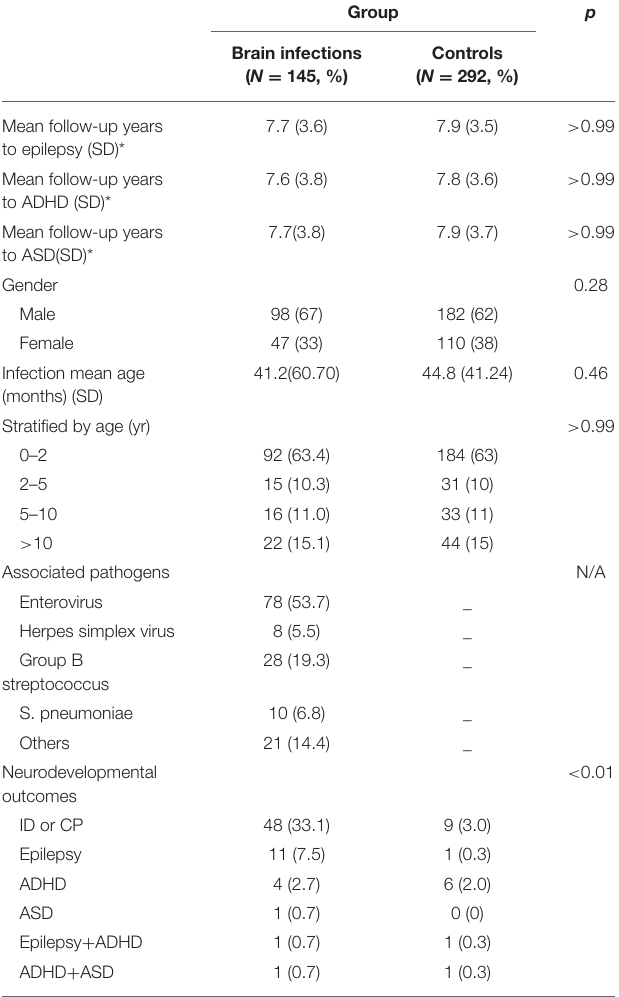
TABLE 1 | Comparison of demographics between brain infections and controls. Group p Brain infections ( N = 145,